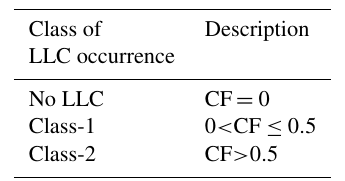
Table 1. Definitions of the three classes of LLC occurrence based on cloud fraction.